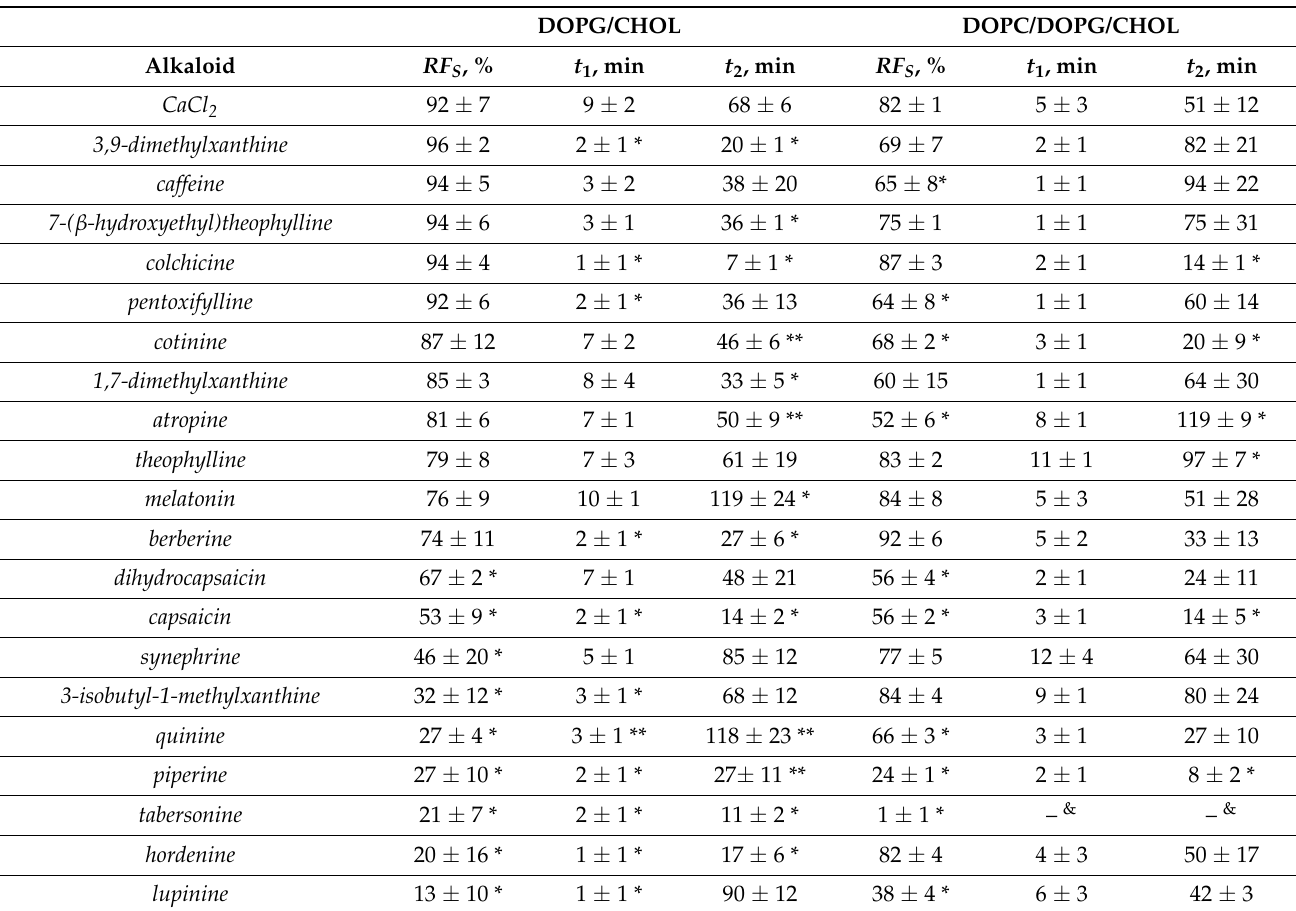
Table 1. The parameters characterized the effects of alkaloids on the calcein release caused by the calcium-mediated fusion of liposomes composed of DOPG/CHOL (80/20 mol%) and DOPC/DOPG/CHOL (40/40/20 mol%).